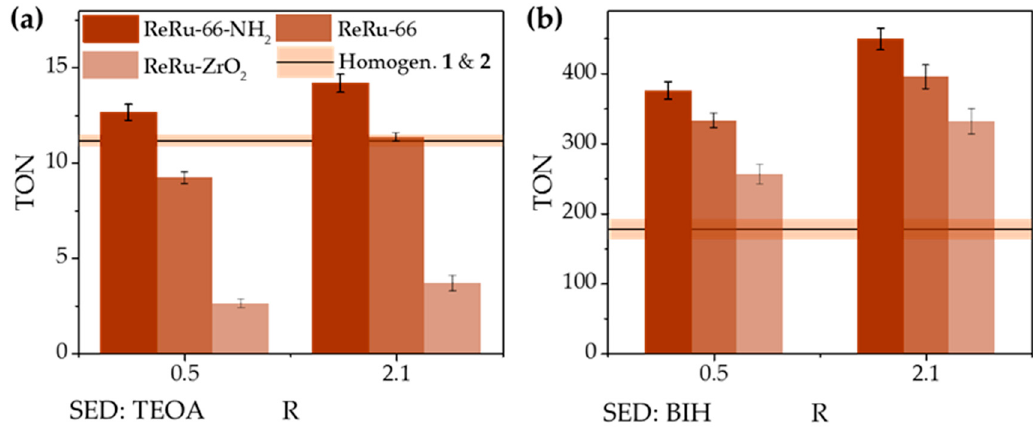
Figure 4. Photocatalytic CO 2 reduction to CO with various host-guest assemblies with differing dye-to-catalyst ratios R and either TEOA or BIH as the electron source. Standard conditions: MeCN, 1.5 mmol SED, room temperature, 2.5 mg sample, irradiation at 450 nm. Homogeneous reference TON with pure 2 and 1 depicted as a horizontal black line with the respective error margins. ( a ) Experiments with TEOA, final TON attained after 5 h. ( b ) Experiments with BIH, final TON attained after 10 h.